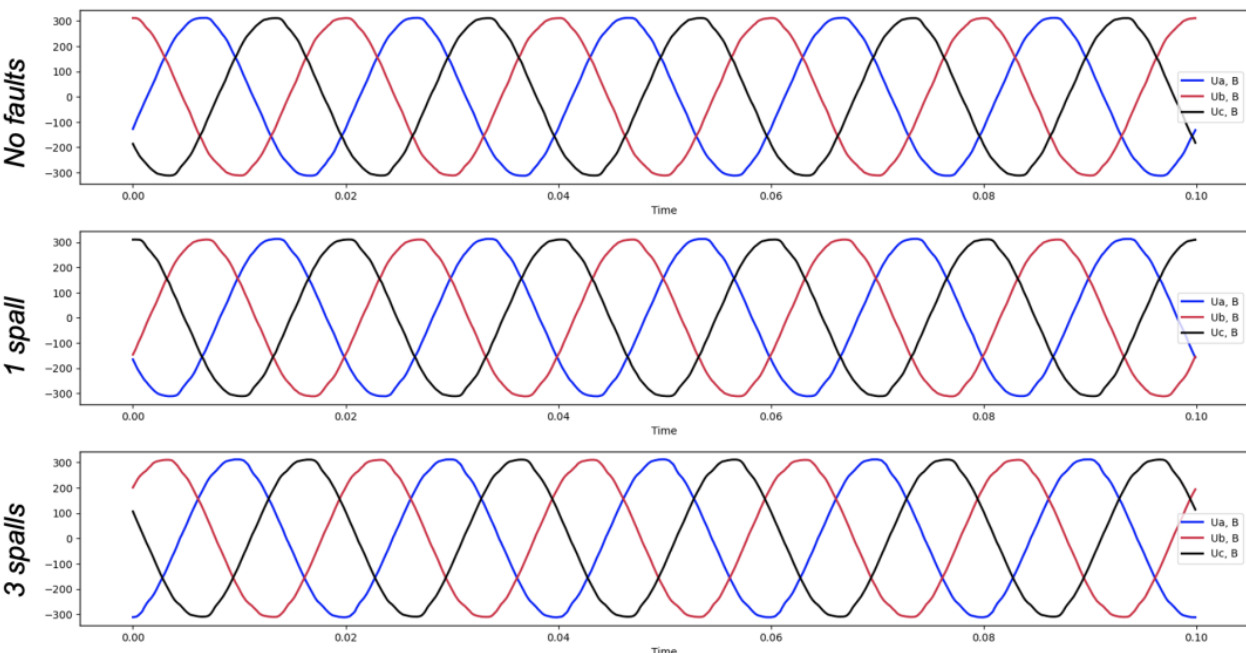
Figure 4. Voltage signals for the bearing without faults, the bearing with one spall and the bearing with three spalls.